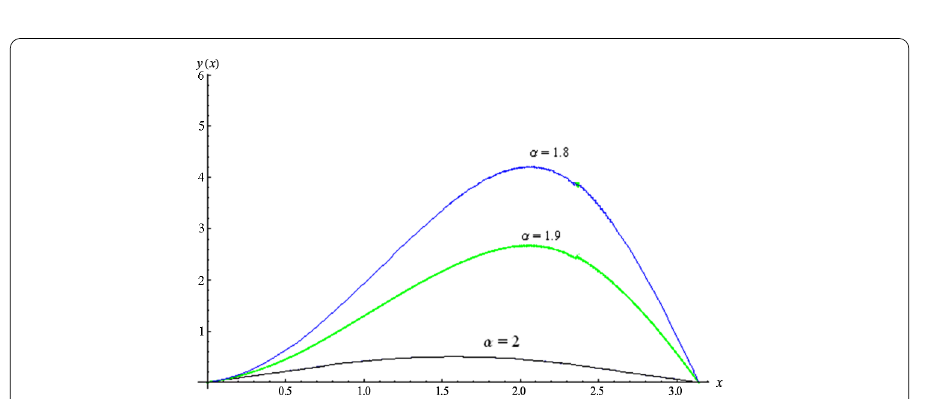
Figure 3 The RKHS solutions of BVP (4.3) for different values of